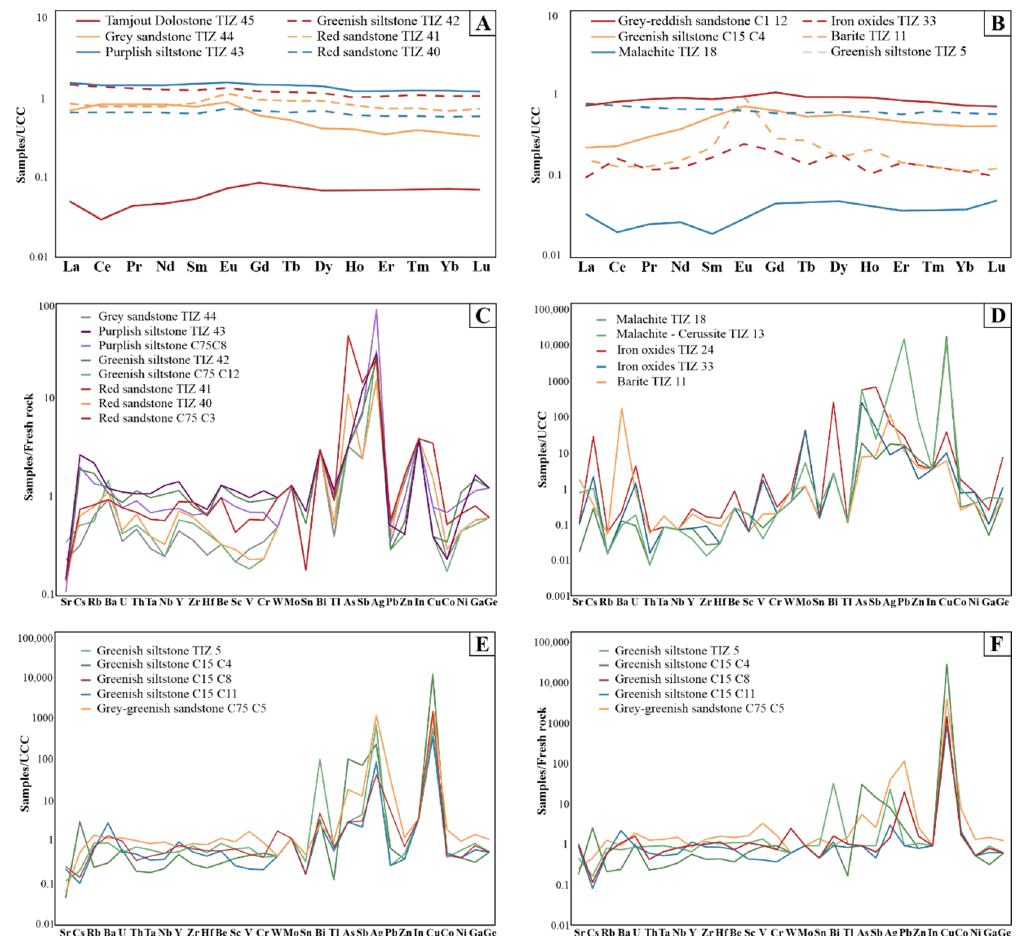
Figure 4. Geochemical data: ( a ) REE (Rare Earth Elements) patterns for fresh rocks (Tamjout Dolomite and Basal Series), with values normalized to UCC (Upper Continental Crust [44]); ( b ) REE patterns for weathered samples with values normalized to UCC; ( c ) trace elements patterns for fresh host rocks (Basal Series), with values normalized to UCC ( d ) trace elements patterns for main mineral phases in the Tamjout Dolomite, with values normalized to UCC. ( e ) trace elements patterns for weathered greenish siltstone/sandstone, with values normalized to UCC; ( f ) trace elements patterns for weathered greenish siltstone/sandstone, with values normalized to fresh greenish siltstone.